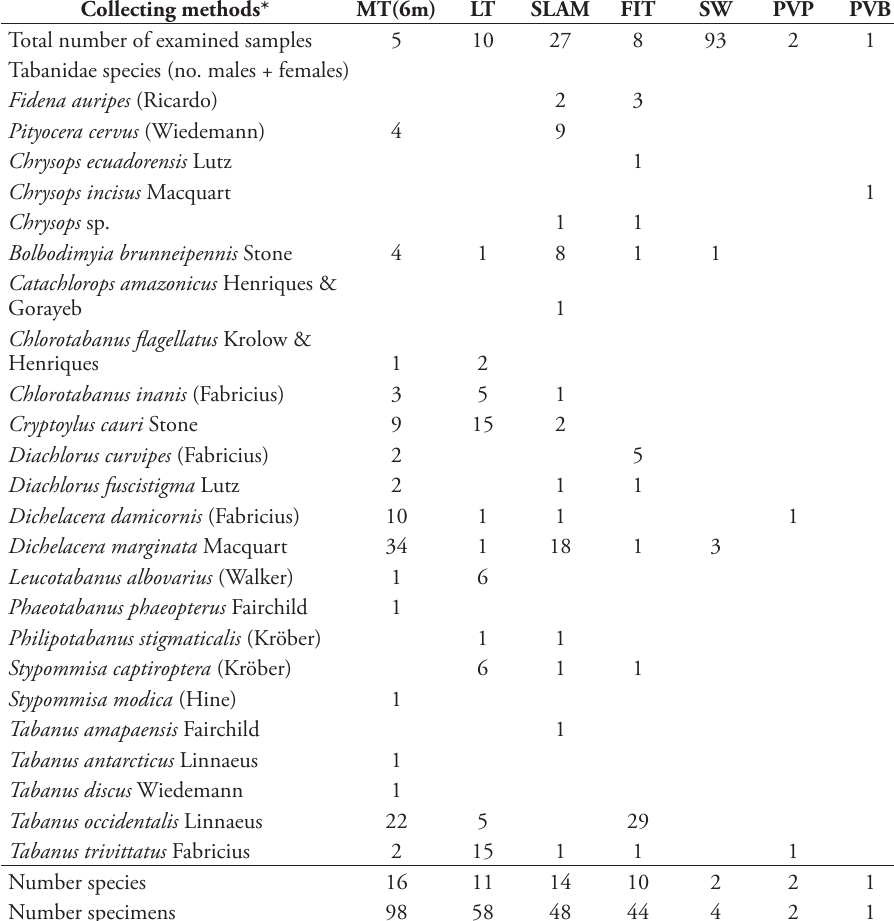
Table 1. Overview of sampling methods that yielded Tabanidae during the Mitaraka 2015 survey. Collecting methods* Total number of examined samples Tabanidae species (no. males +